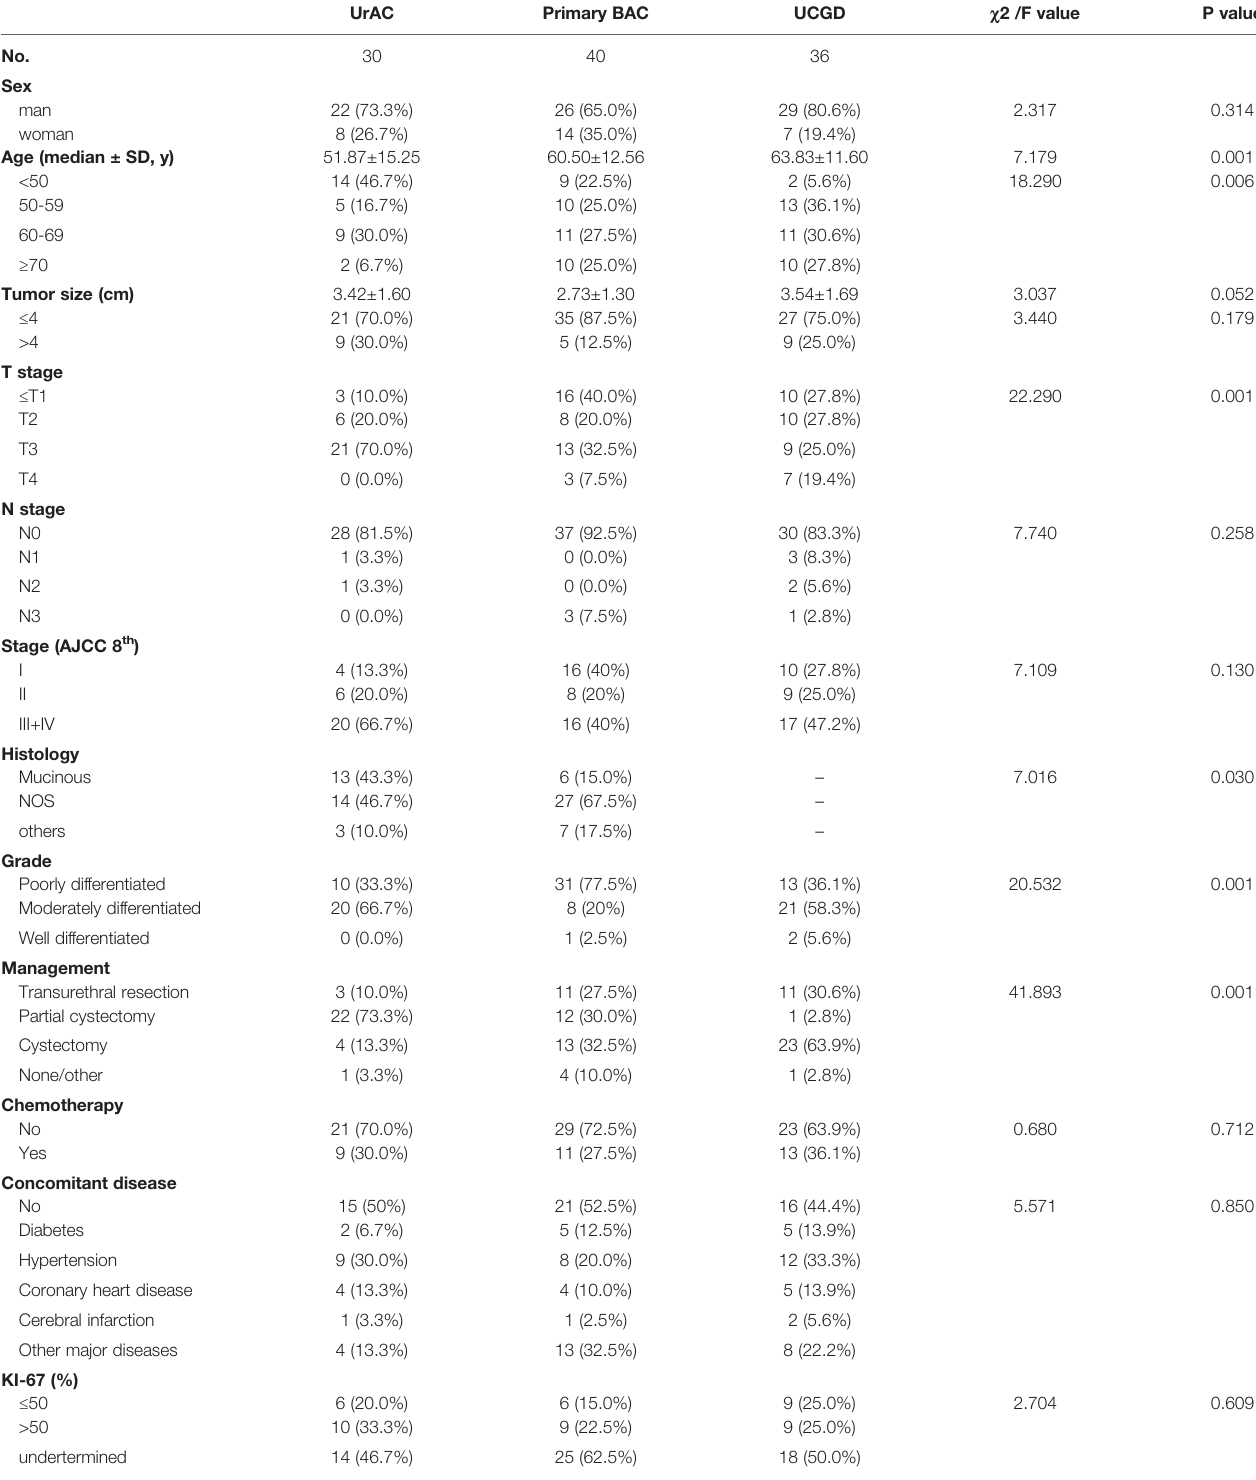
TABLE 1 | Patient ’ s baseline